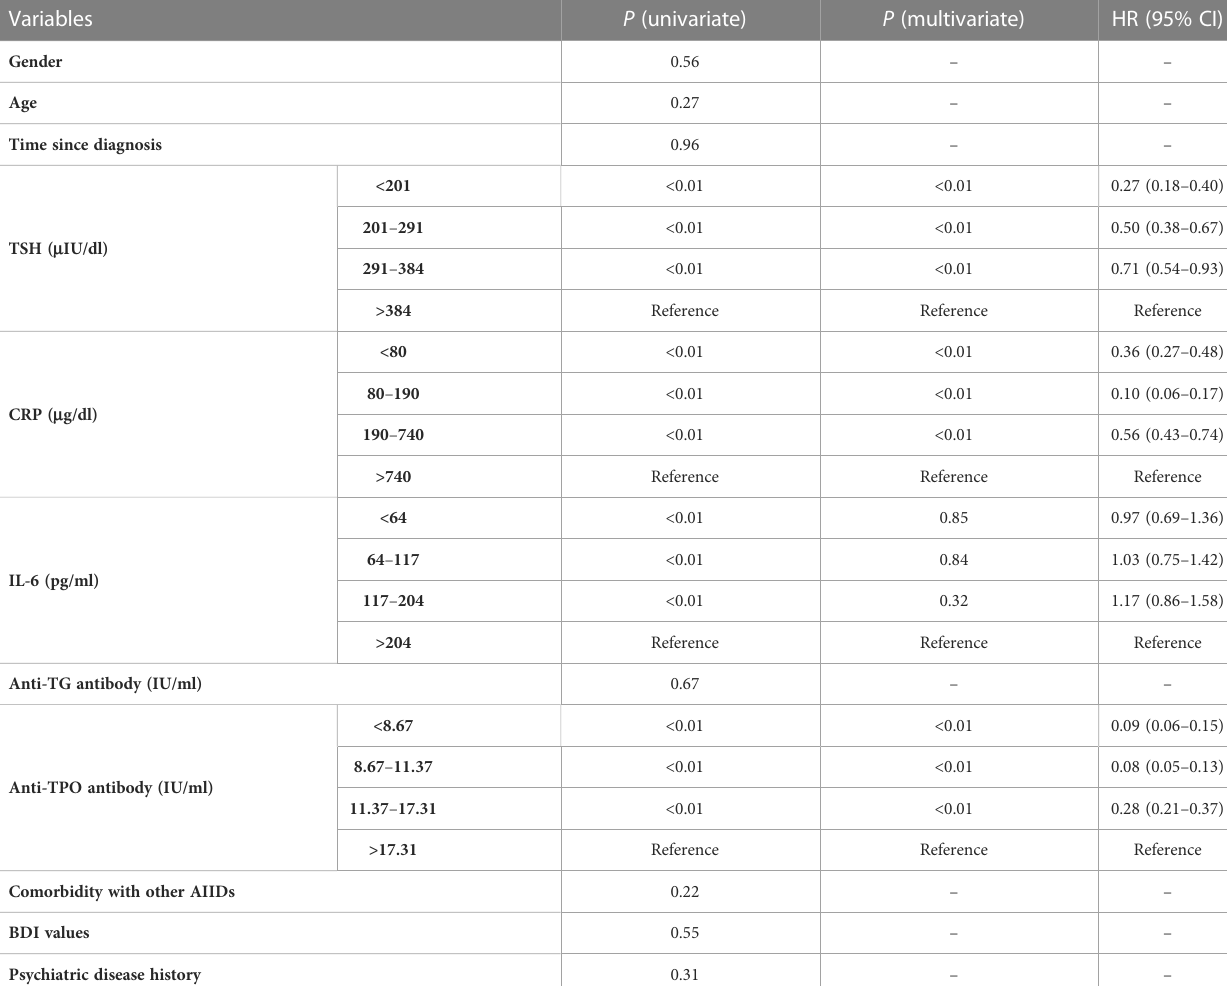
TABLE 2 Survival analysis of incident mood changes after vaccination.